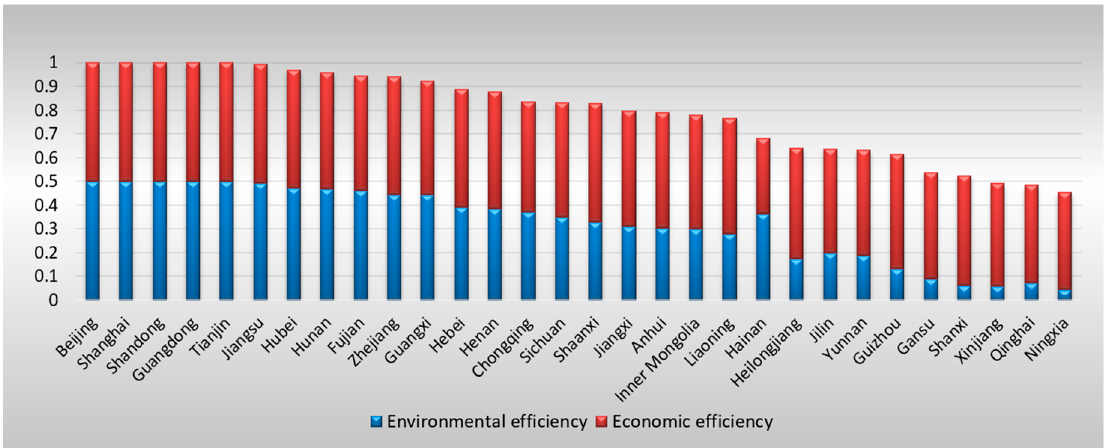
Figure 4. Average final EEE for provinces (2012–2016) in Stage 3.